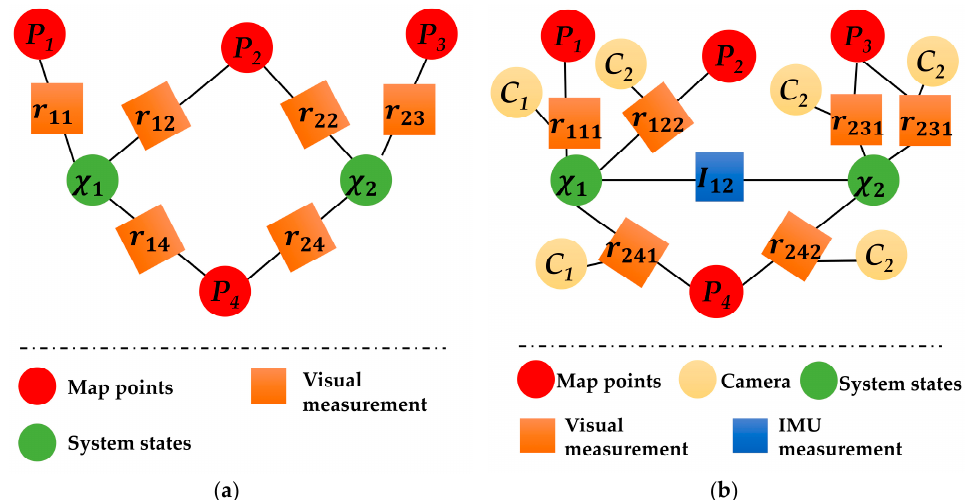
Figure 7. The different factor graphs. ( a ) factor graph of common visual odometry (VO) method; ( b ) factor graph of the proposed VINS-MKF.